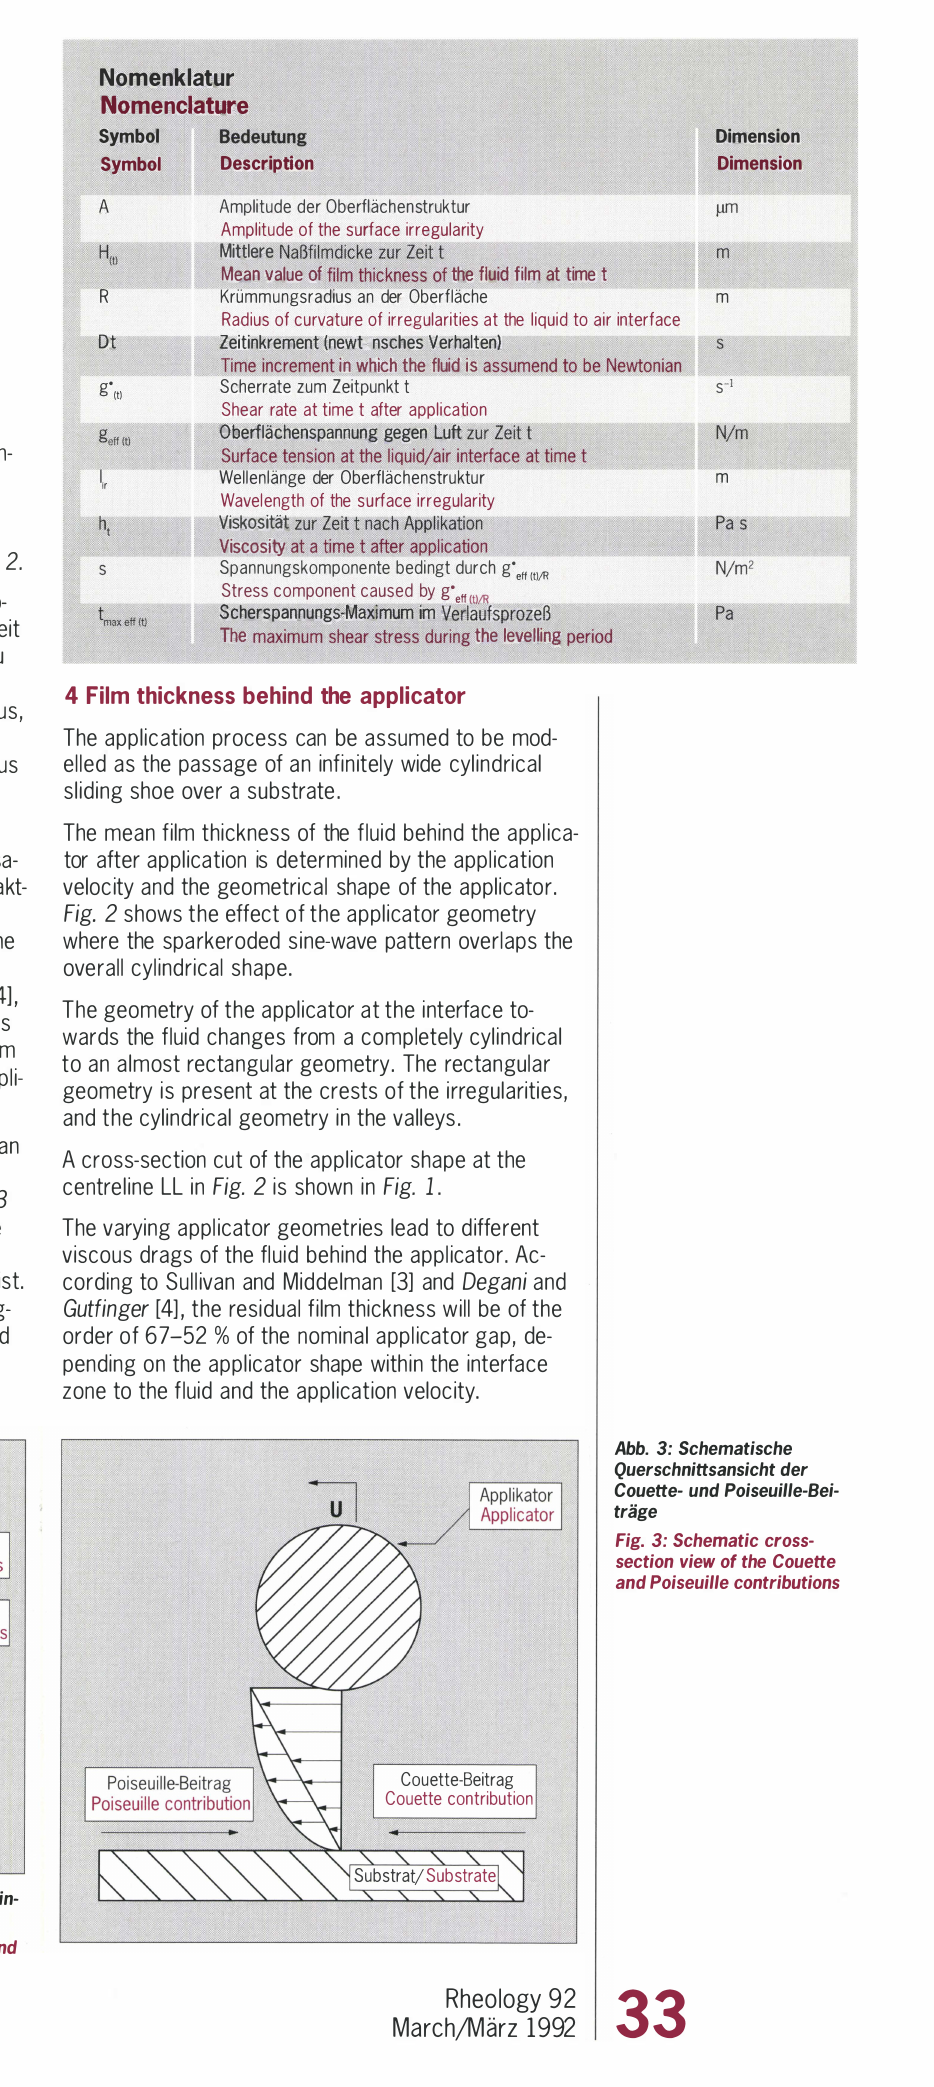
Fig. 2: Schematic cross-section view of the flow profile behind the applicator